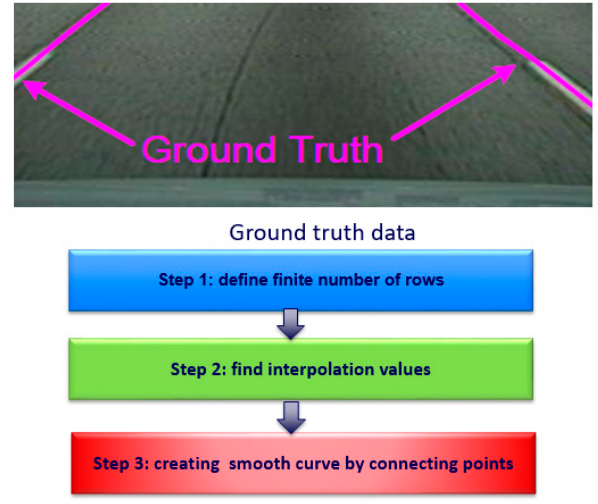
Figure 6. Summary of steps involved in the interpolation